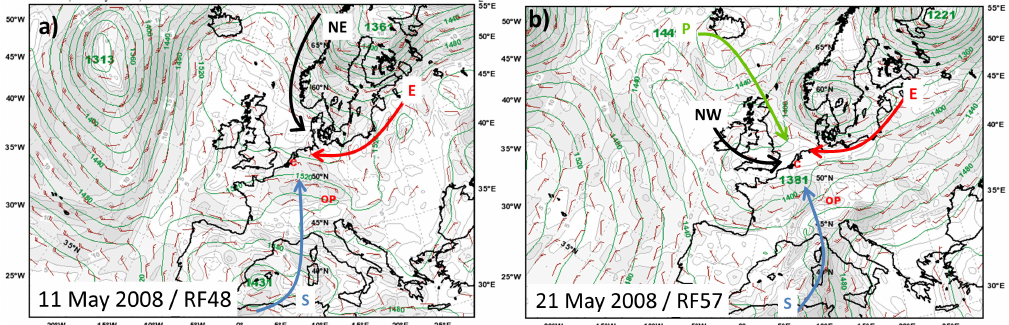
Fig. 2. Geopotential and wind speed at 850hPa for (a) anticyclonic and (b) cyclonic conditions. The arrows correspond to a mean direction of air mass trajectories approaching the measurement location. The different air mass sectors are NW: north-west Europe; S: south Europe; NE: north Europe; E: east Europe; and P: polar; they correspond to cases outlined in Tables 1–4 and in the next